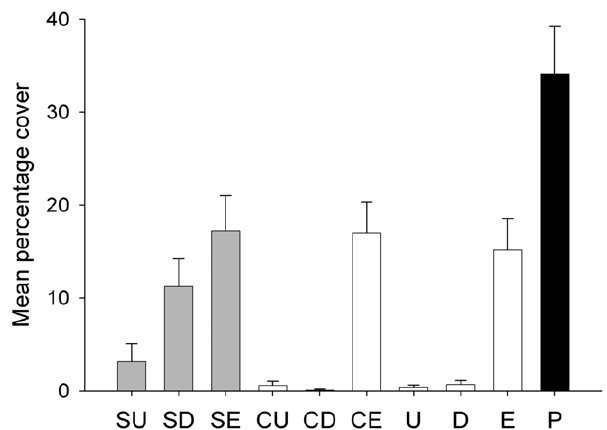
Figure 1. Covers of bryozoans on kelps on reefs after experimental exclusion of urchins and shading. Mean ( 6 S.E.; n =8) percentage cover of bryozoans on kelps 1 month after experimental exclusion of urchins and shading. Treatments are: Shade Undisturbed (SU), Shade Disturbed (SD), Shade Excluded (SE), Control Undisturbed (CU), Control Disturbed (CD), Control Excluded (CE), Undisturbed reefs (U), Disturbed (D), Excluded (E) and Undisturbed Pilings (P).